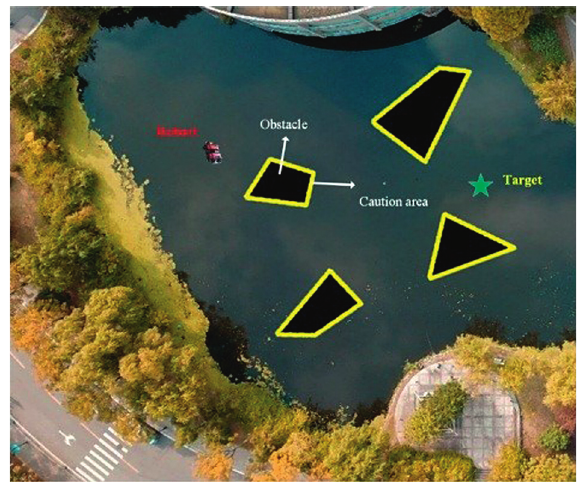
Figure 15: Experimental environment on the lake.